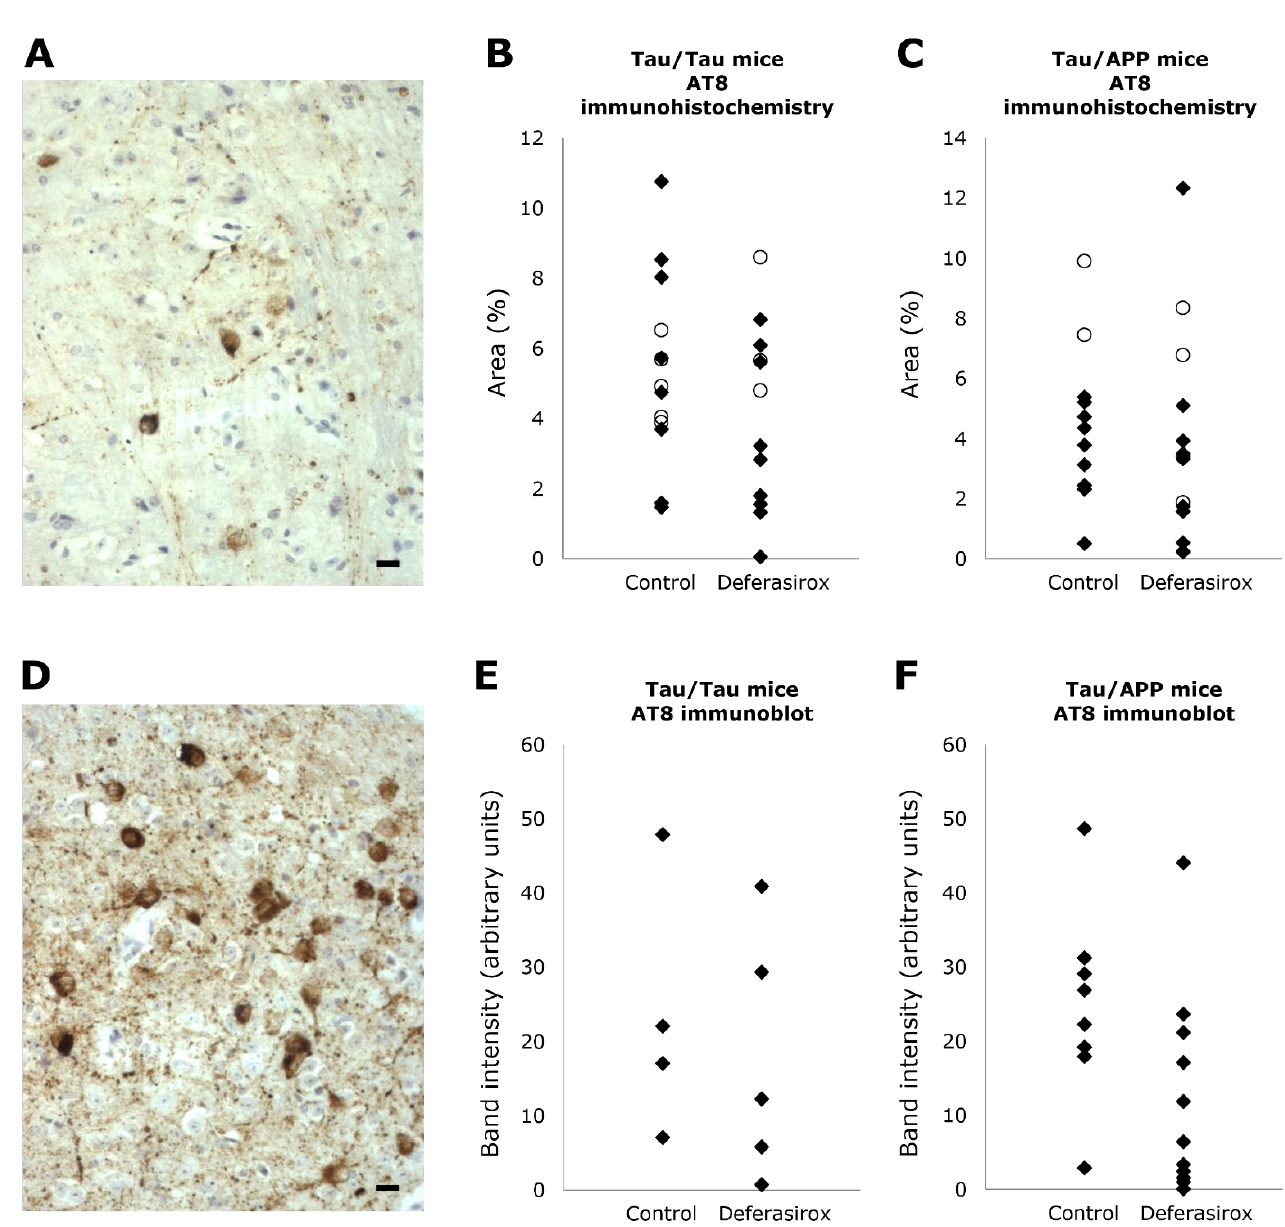
Figure 4. AT8 antibody immunoreactivity. Examples ( A , D ) of AT8 immunoreactivity in coronal medulla sections of Tau/APP mice treated with ( A ) or without deferasirox ( D ) (scale bar is 25 µ m). Comparing immunoreactivity of deferasirox-treated mice with untreated mice, the mean area occu- pied by neurofibrillary tangles in medulla sections was 25% less in Tau/Tau mice ( B , p = 0.22) and 21% less in Tau/APP mice ( C , p = 0.57), and the immunoblot band intensity was 24% less in Tau/Tau mice ( E , p = 0.64) and 53% less in Tau/APP mice ( F , p = 0.034). Males are black diamonds, and females are white circles. Because few female brains were available for homogenization, only male samples were immunoblotted.